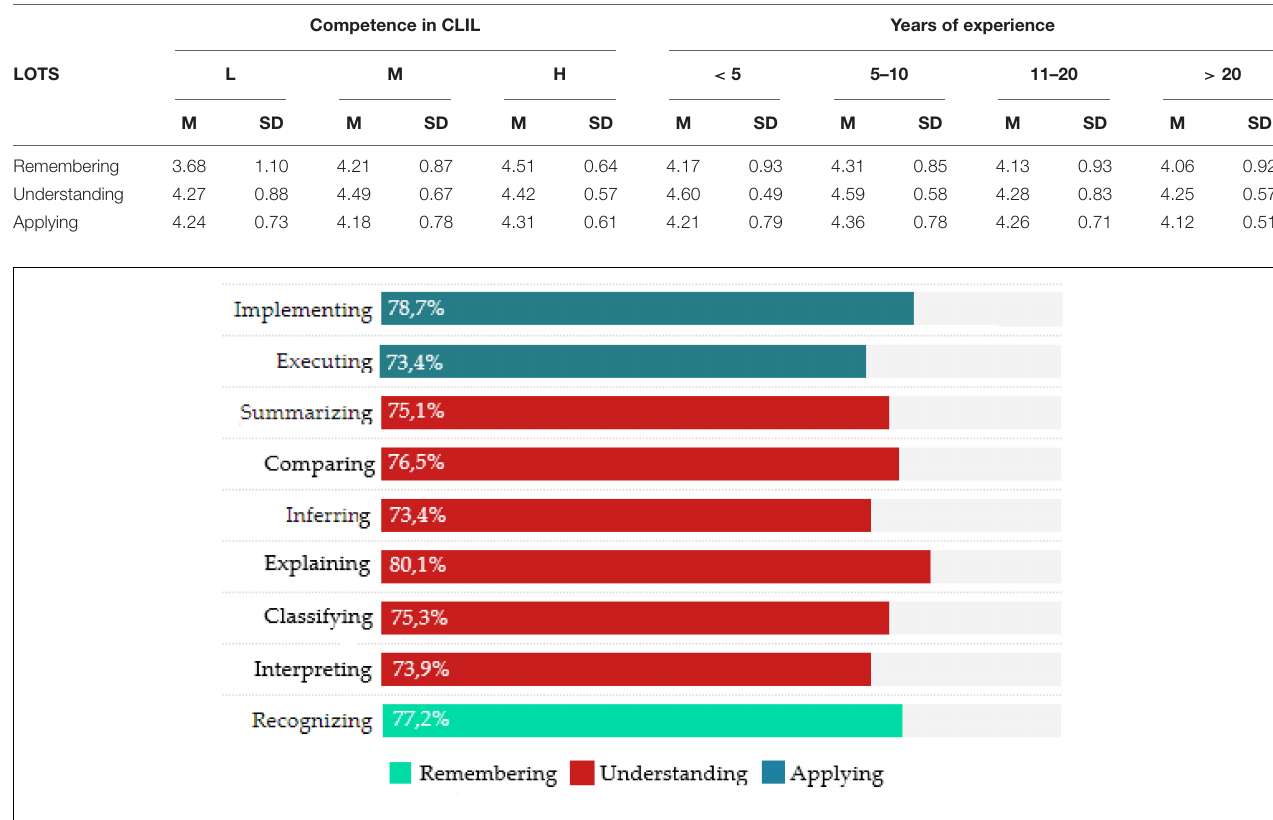
FIGURE 1 | Development of cognitive processes associated with low-order cognitive skills